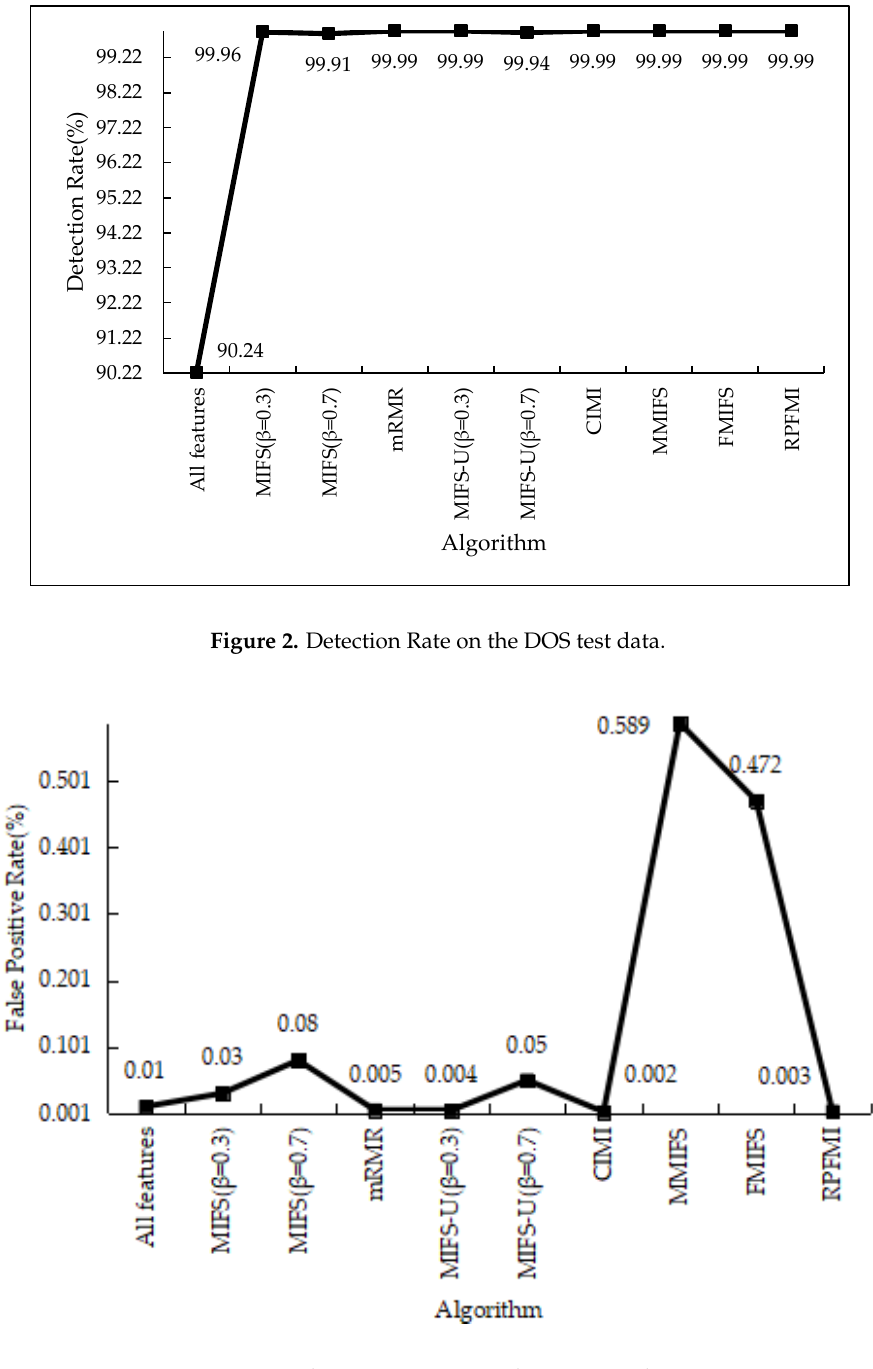
Figure 3. False Positive Rate on the DOS test data.